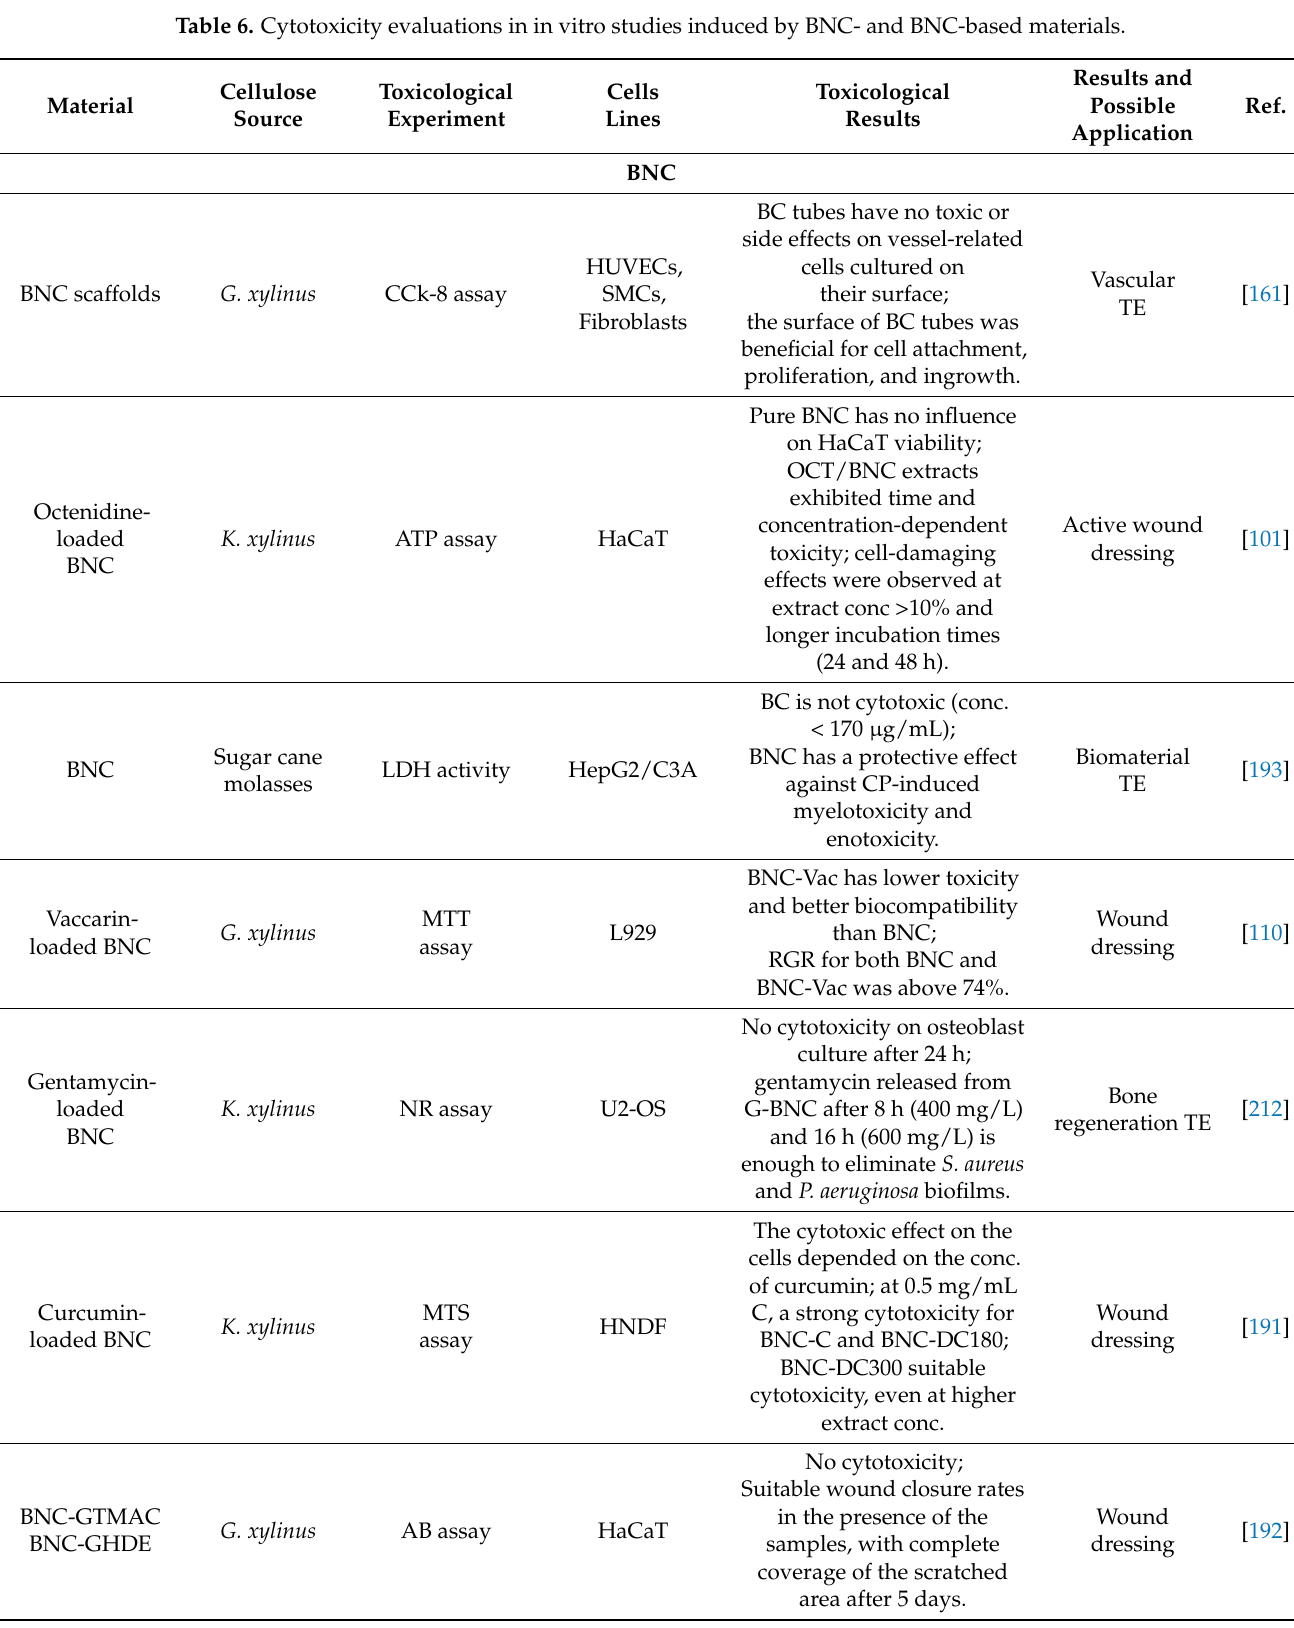
Table 6. Cytotoxicity evaluations in in vitro studies induced by BNC- and BNC-based materials.